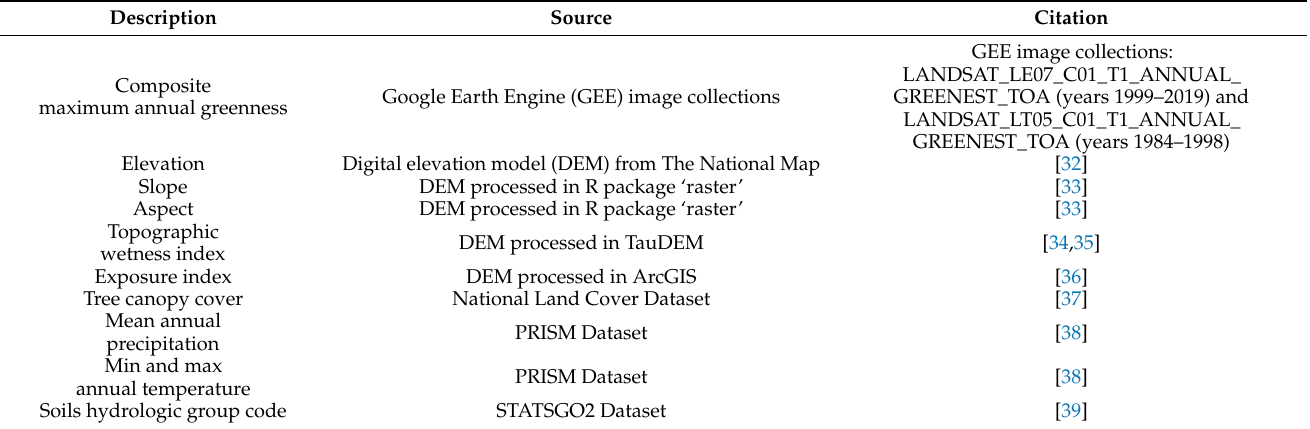
Table 3. Predictor variables used in all random forests models for predicting